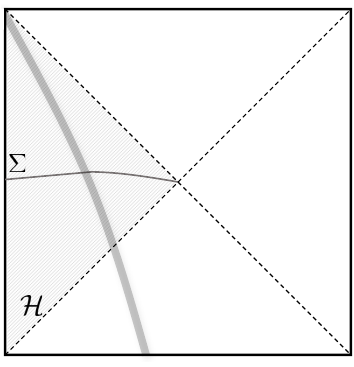
Figure 2 . Matter infalling across the past horizon H of a dS static